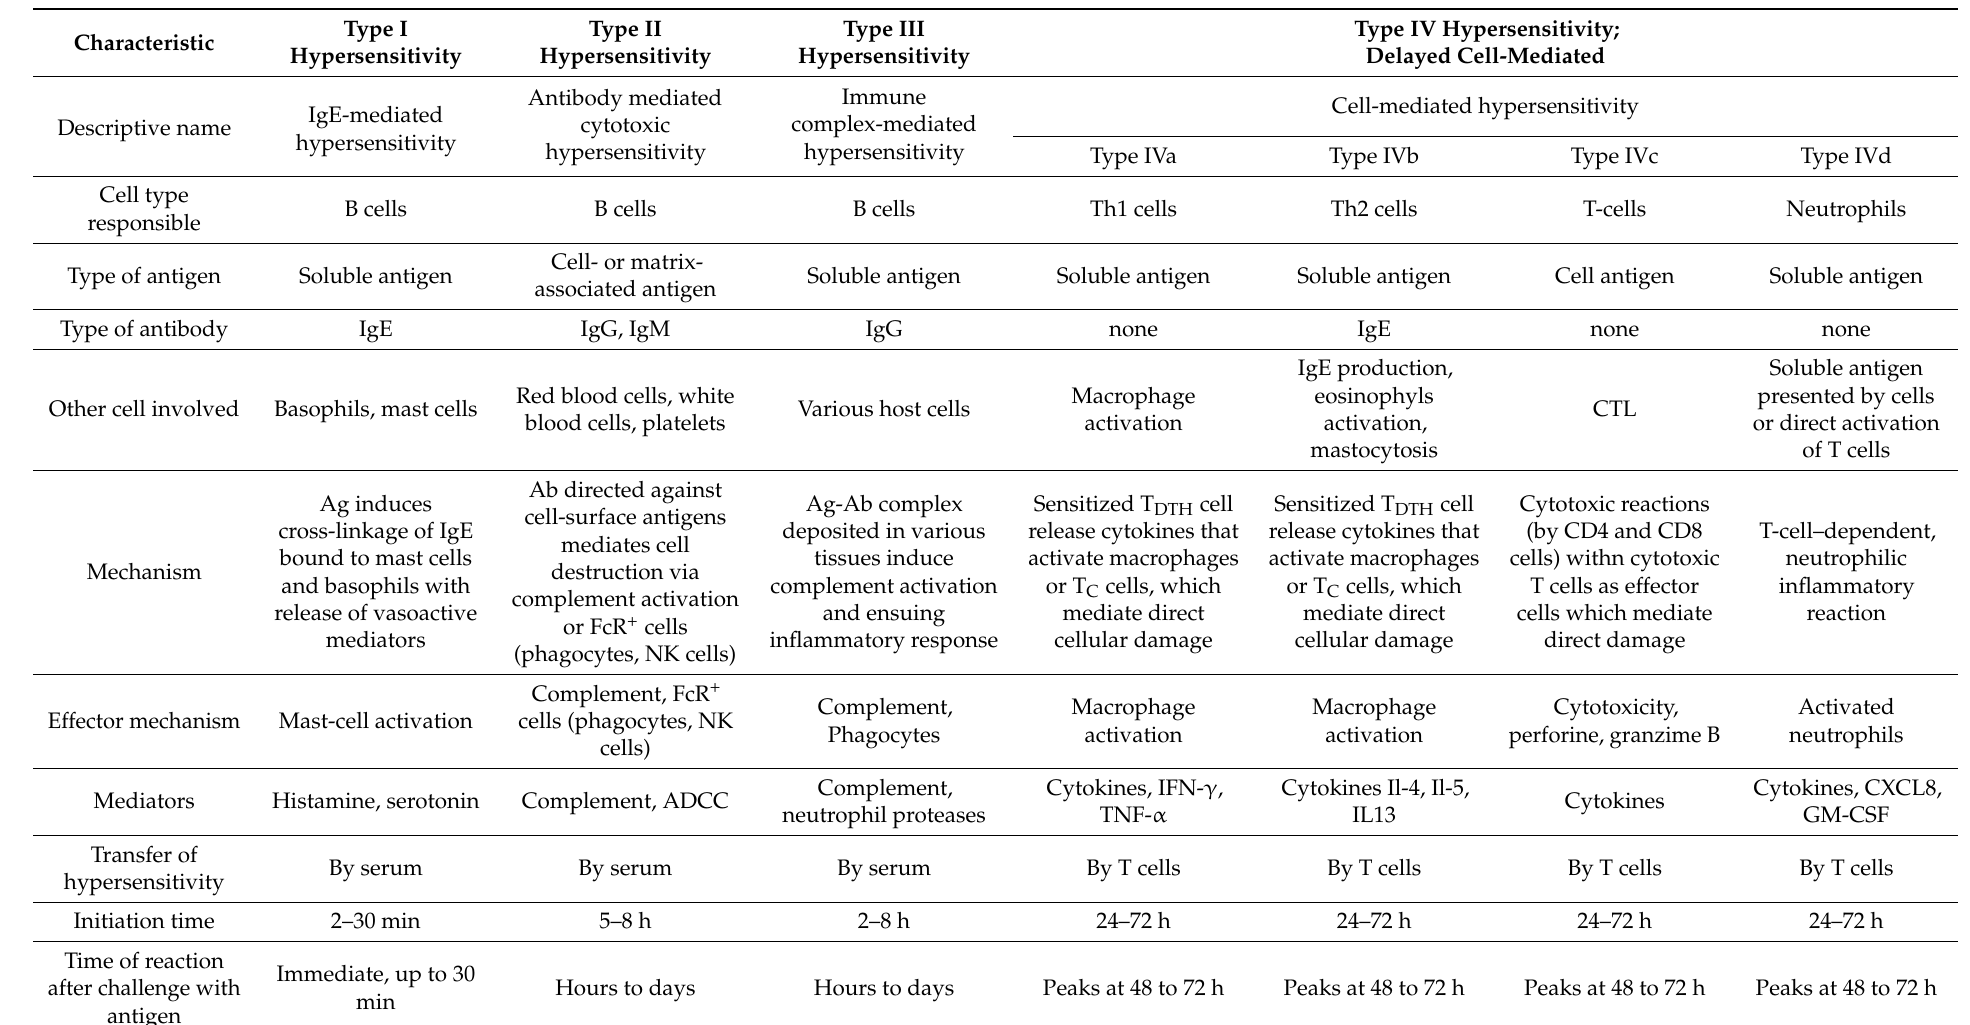
Table 1. Gell and Coombs classification of hypersensitive reaction and some characteristics of the major of